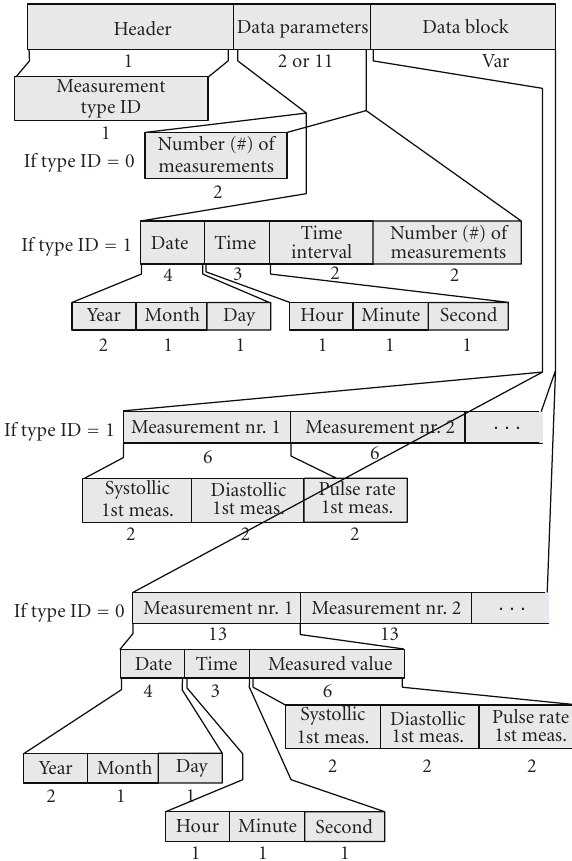
Figure 4: Overview of the data part holding the systolic-diastolic blood pressure data (Section-203).